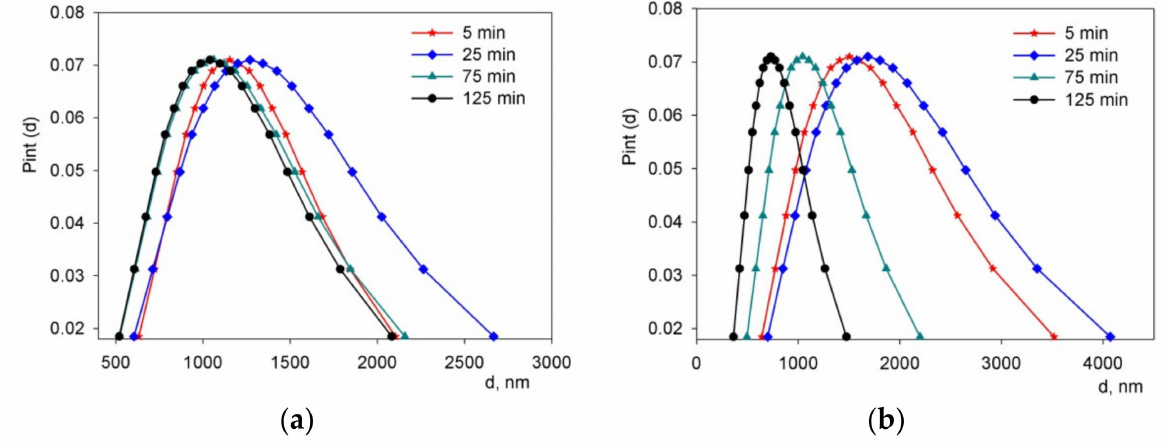
Figure 4. Unimodal distributions of the aggregate size in suspensions after ultrasonic treatment for 5, 25, 75, and 125 min: ( a ) BCZYYbO-CuO; ( b ) SDC. P int (d) is a probability density of unimodal distribution of aggregates by